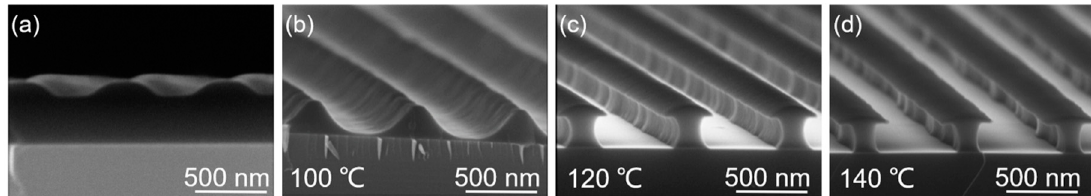
Figure 5. The effect of crosslinking-bake temperature of top negative photoresist AR-N 4340 with the same time of 120 s on the morphology of photoresist developing with 1.6% tetramethylammonium hydroxide (TMAH). ( a ) The SEM image of photoresist before developing. ( b ) The SEM image of photoresist with crosslinking-bake temperature of 100 °C, developing for 10 s. ( c ) The SEM image of photoresist with crosslinking-bake temperature of 120 °C, developing for 40 s. ( d ) The SEM image of photoresist with crosslinking-bake temperature of 140 °C, developing for 80 s.